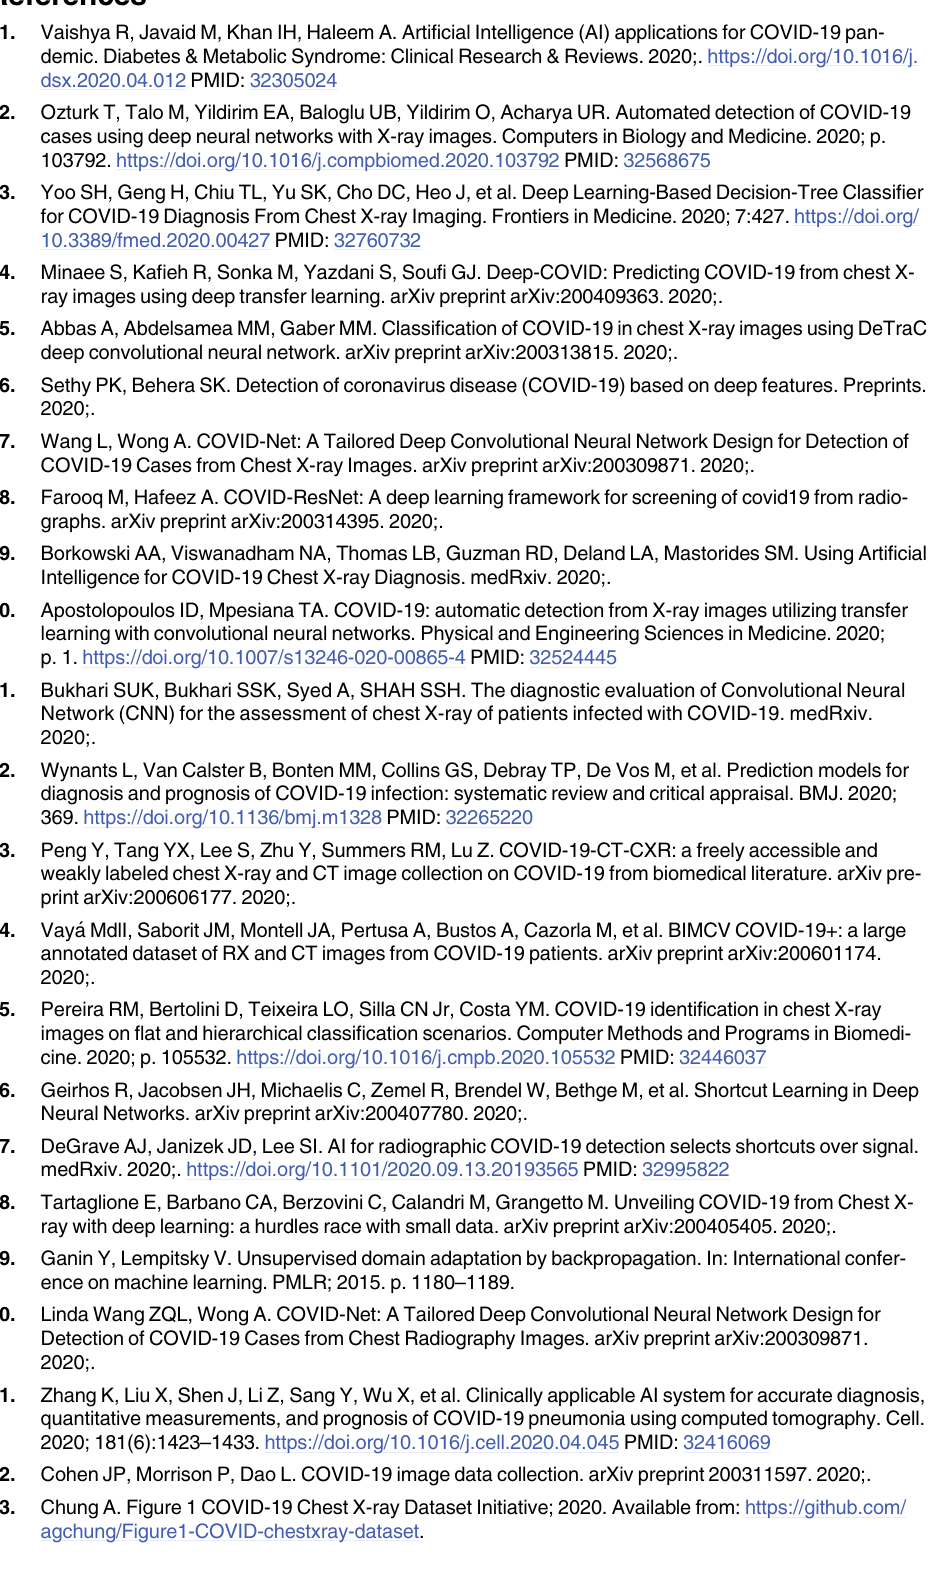
23. ChungA. Figure 1 COVID-19 Chest X-ray Dataset Initiative; 2020. Available from: https://github.com/ agchung/Figure1-COVID-chestxray-dataset.